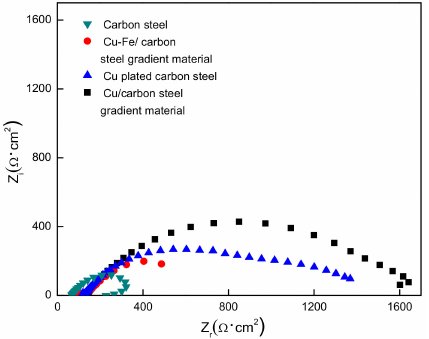
Figure 6. EIS of carbon steel and Cu-Fe alloy in 3.5% NaCl